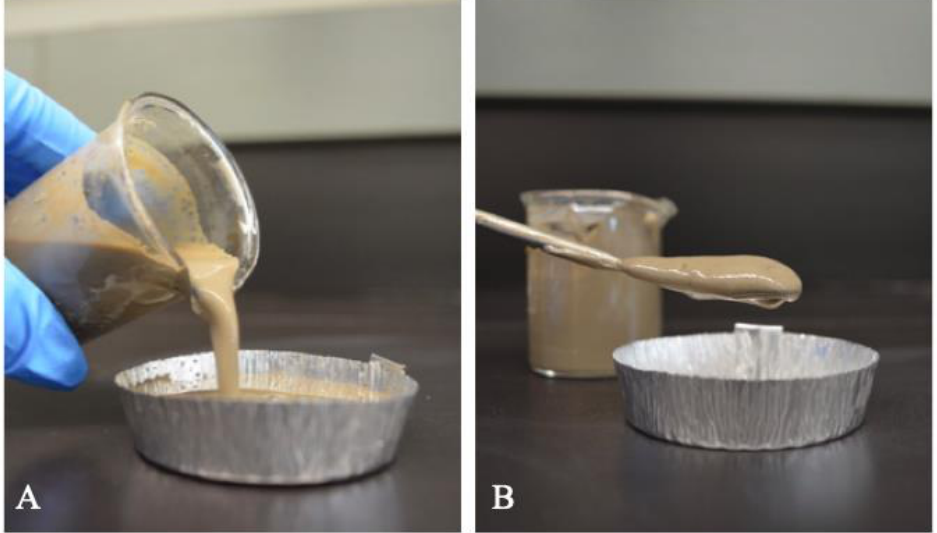
Figure 1. Untreated fluid fine tailings (FFT) ( A ) and thickened tailings ( B ). Combined management of FFT and beach sand produces fines-enriched sand tail- ings: CT or NST. CT is a mixture of FFT, coarse tailings sand, and a coagulant (often gyp- sum) and has a solids content of approximately 60 wt% and a wet density of 2000 kg/m 3